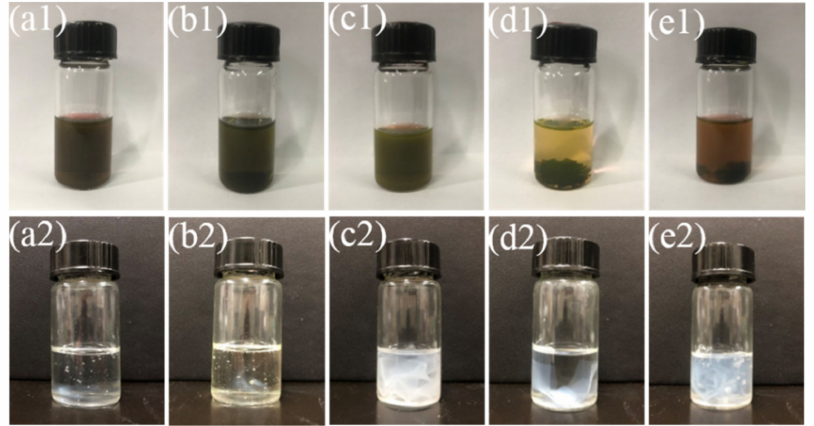
Figure 9. Photos of PWPU 5000 with a mass of 0.5 g soaking in different solvents (4 mL) at 25 ◦ C for 3 h. ( a1 ) DMF, ( b1 ) NMP, ( c1 ) acetone/ethanol ( v / v = 2:1), ( d1 ) acetone, ( e1 ) ethanol; Photos of BWPU 5000 with a mass of 0.5 g soaking in different solvents (4 mL) at 25 ◦ C for 3 h. ( a2 ) DMF, ( b2 ) NMP, ( c2 ) acetone/ethanol ( v / v = 2:1), ( d2 ) acetone, ( e2 )